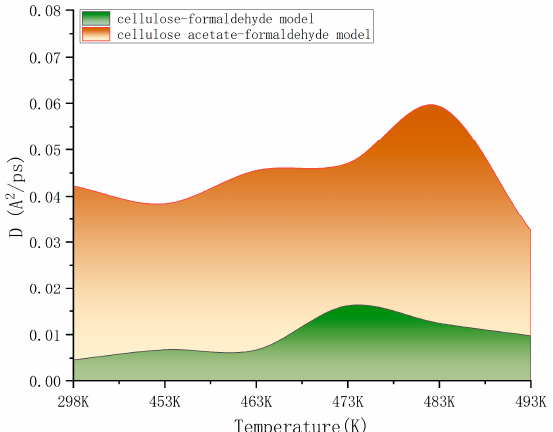
Figure 6. Comparison of di ff usion coe ffi cients.